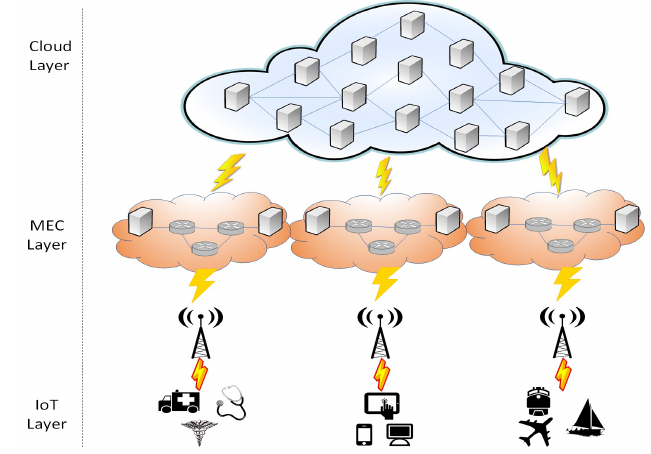
Figure 1. Cloud-based Internet of Things